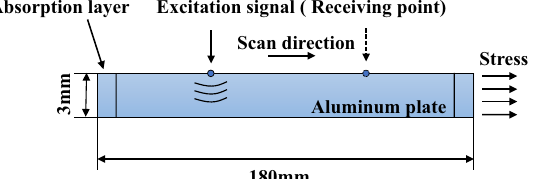
Figure 7 Schematic of the FE model